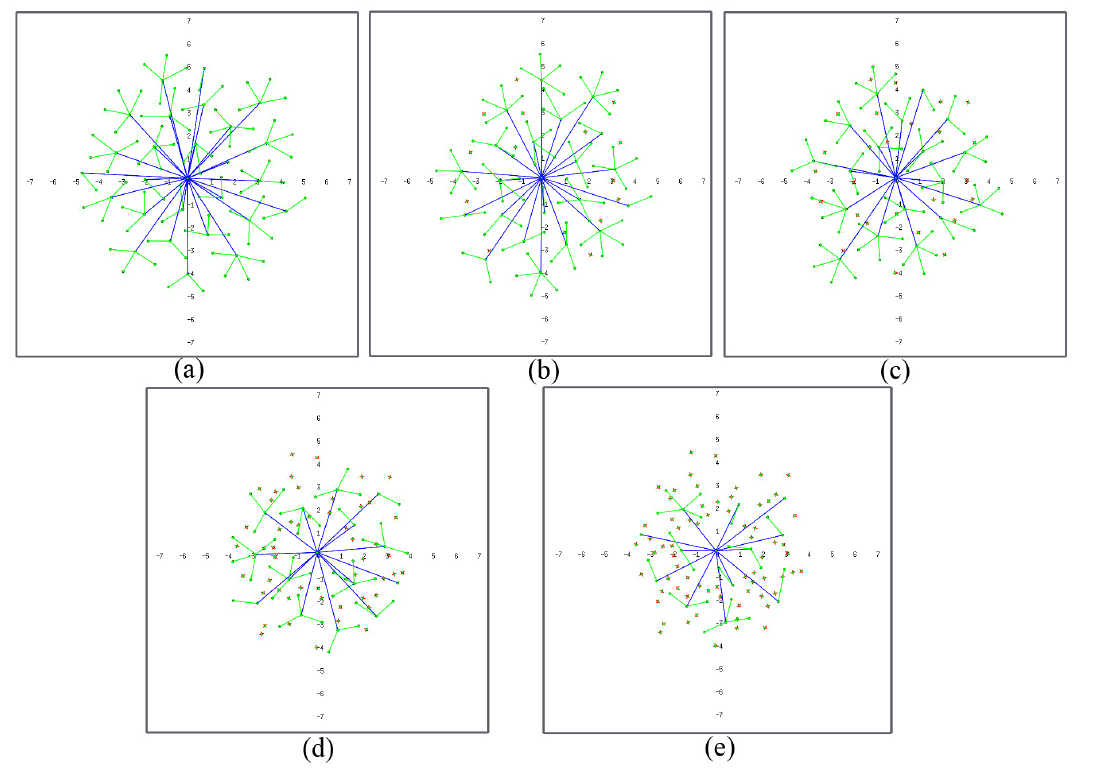
Figure 10. Network configuration when: ( a ) 0%; ( b ) 12.5%; ( c ) 25%; ( d ) 50% and ( e ) 70% of the nodes are dead (figures are scaled 1:10 m).